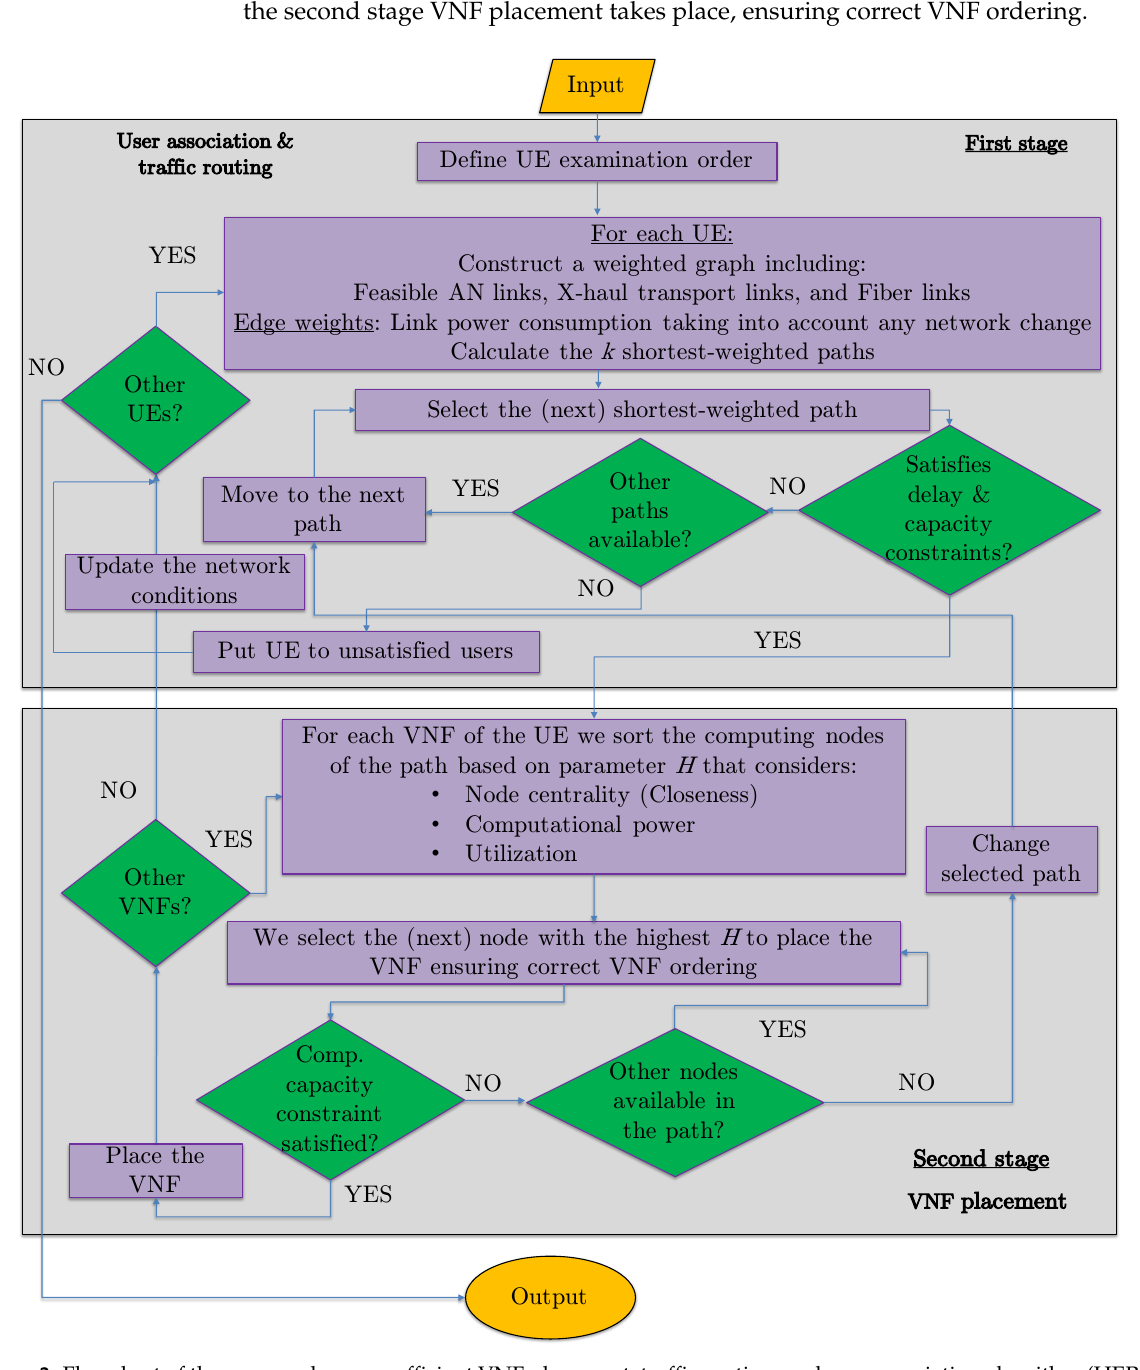
Figure 3. Flowchart of the proposed energy-efficient VNF placement, traffic routing, and user association algorithm